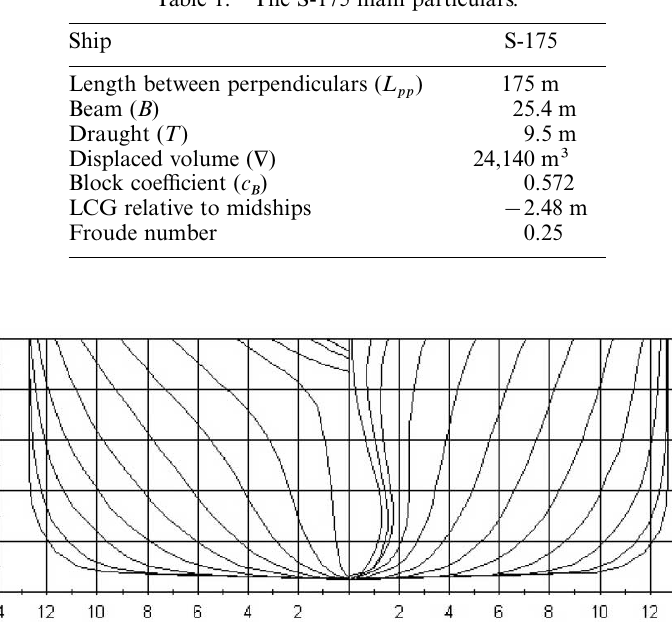
Figure 7. Body plan of the S-175 container